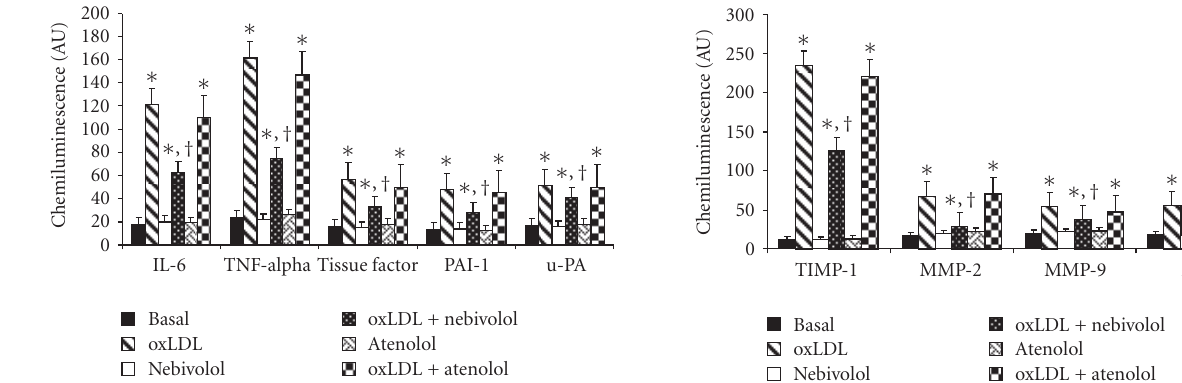
Figure 2: E ff ect of nebivolol and atenolol on RNA expression of proteins linked to inflammation (IL-6 and TNFalpha) and to thrombotic state (tissue factor, PAI-1, and uPA) induced by oxida- tive stress in human umbilical vein endothelial cells (HUVECs). HUVECs were incubated with nebivolol or atenolol (10 μ M) for 24 hours at 37 ◦ C; oxidative stress was induced by the addition of oxidized (ox)LDL (50 μ g protein mL − 1 ). ∗ P < . 001 versus control; † P < . 01 versus ox-LDL. AU = arbitrary units. Data are expressed as means ± SD of 6 di ff erent experiments.